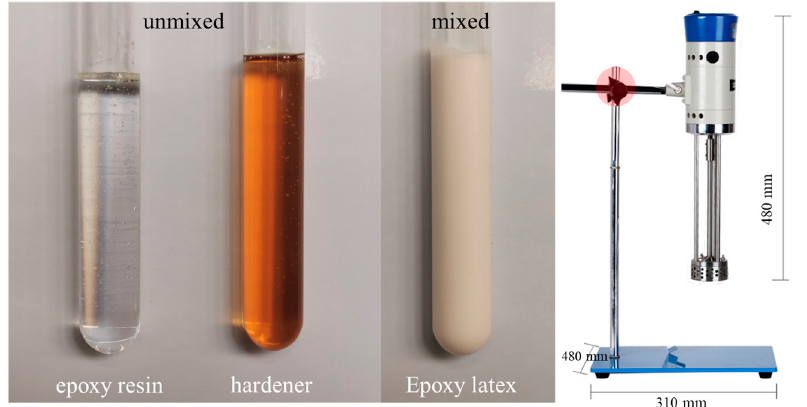
Figure 2. The images of epoxy latexes material of the unmixed stage and mixed stage and the high-speed shear dispersing emulsification tools.